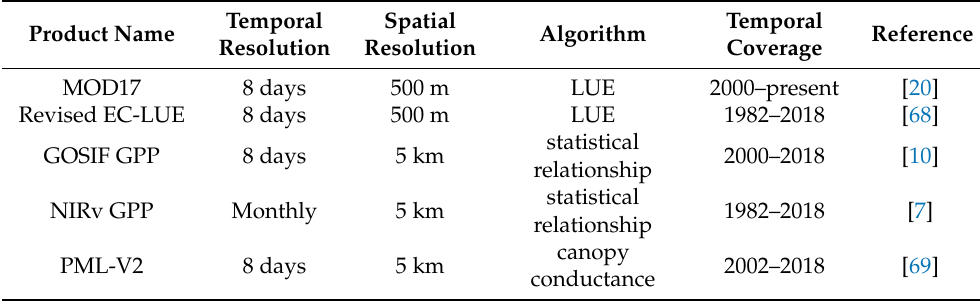
Table 4. Satellite observation-based GPP data products used for intercomparison in this study.